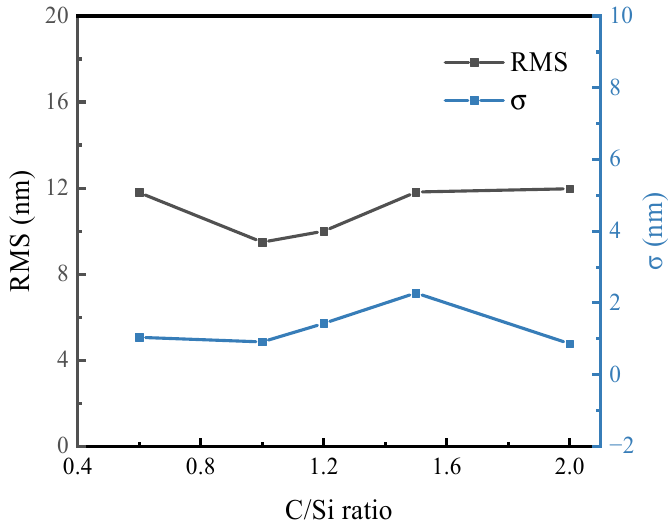
Figure 4. RMS and σ of 4H-SiC epitaxial wafers as a function of C/Si ratio, with C/Si ratios of 0.6, 1.0, 1.2, 1.5, and 2.0, respectively.